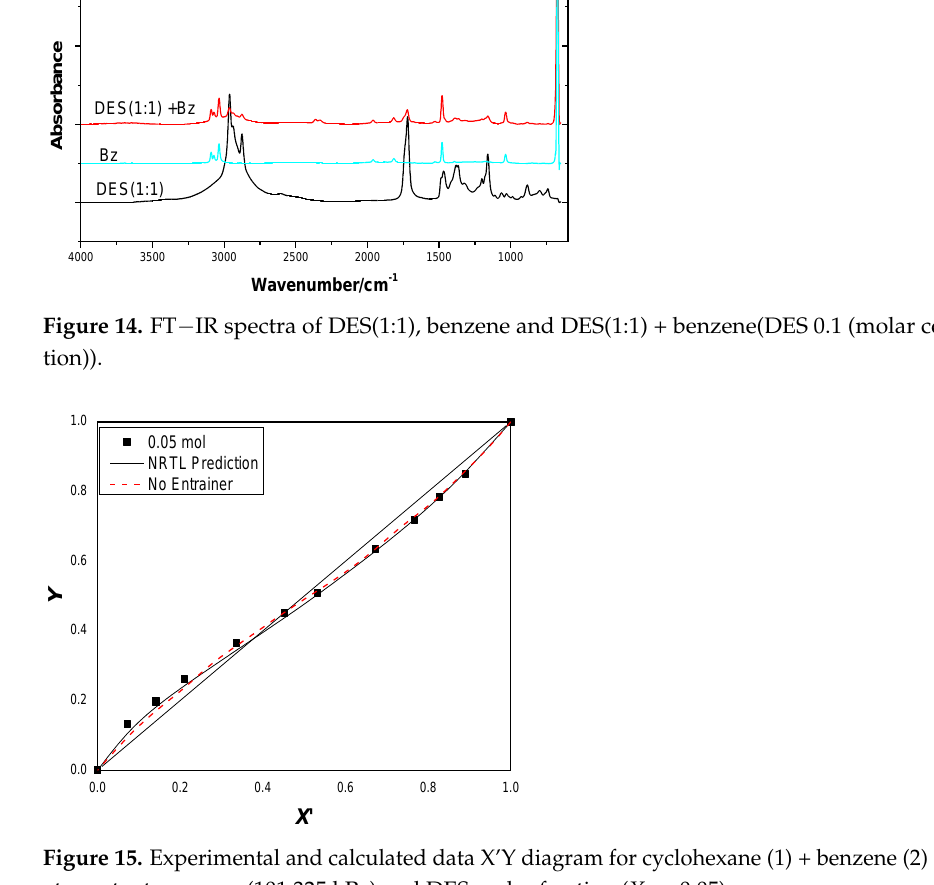
Figure 15. Experimental and calculated data X’Y diagram for cyclohexane (1) + benzene (2) + DES (3) at constant pressure (101.325 kPa) and DES molar fraction ( X 3 = 0.05). Table 10. Coefficient of determination (R 2 ) of the pseudo-ternary systems fitting using the three Table 11. Estimated values for the binary parameters using the NRTL model for correlating the pseudo-binary VLE data. thermodynamic models. DES(1:2) Mole Concentration Comp.